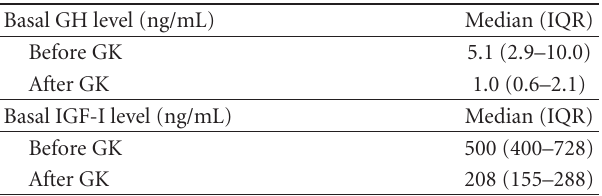
Table 2: Long-term e ff ects of GK on GH and IGF- I levels in patients without medical treatment ( N = 79).